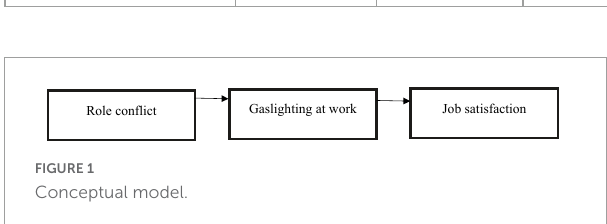
FIGURE1 Conceptual